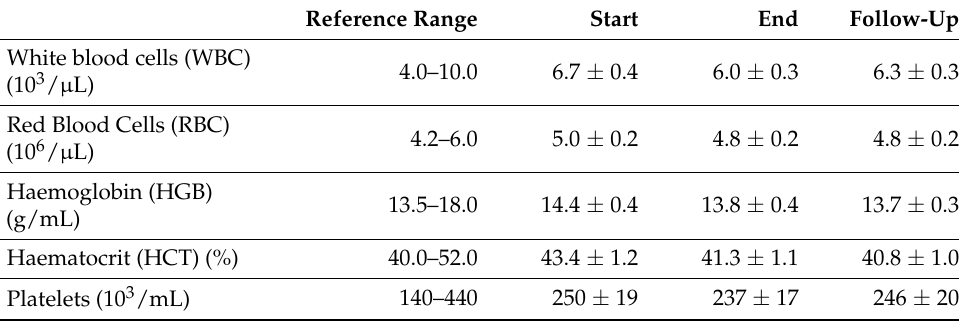
Table 3. Changes in the blood count of the participants during the study.